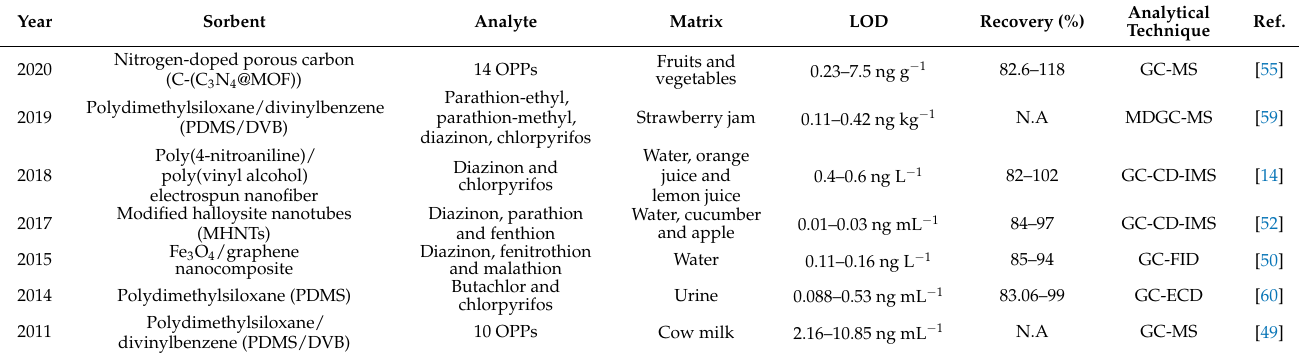
Table 4. Summary of past studies on the applications of SPME as a sample preparation technique for OPPs’ determinations. Year Sorbent Analyte Matrix LOD Recovery (%) Analytical Technique